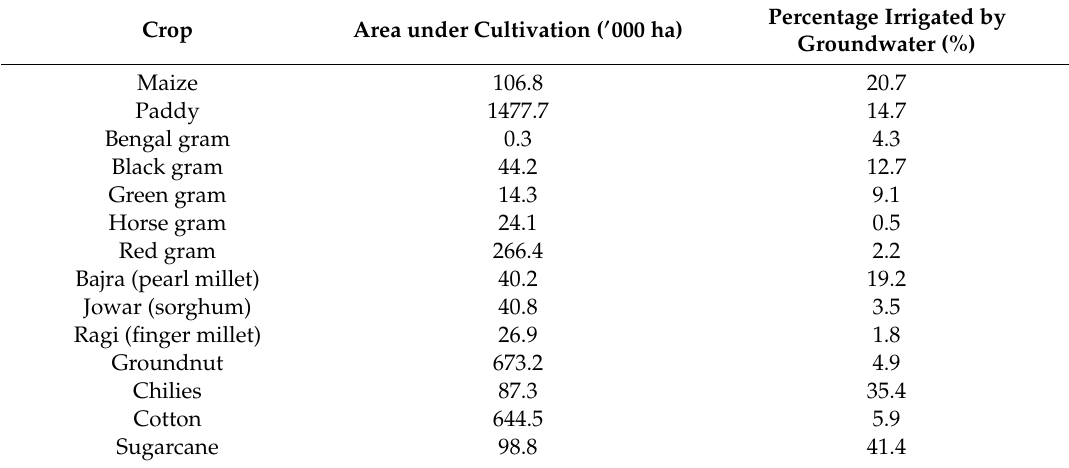
Figure 1. The state of Andhra Pradesh in southern India and the spatial distribution of normal annual rainfall across the districts of Andhra Pradesh. Table 1. Major crops cultivated in Andhra Pradesh in the Kharif season. The area represents the average area under cultivation from 2013 – 2018. The last column is the overall percentage of area under groundwater irrigation in the study area [41].